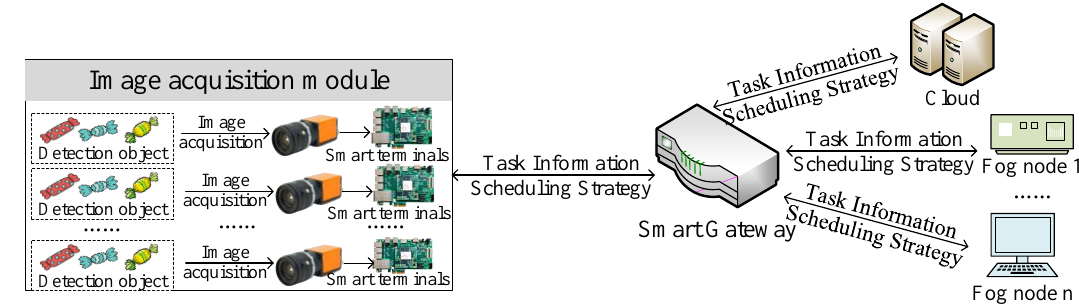
Figure 2. The image processing process of intelligent production lines.